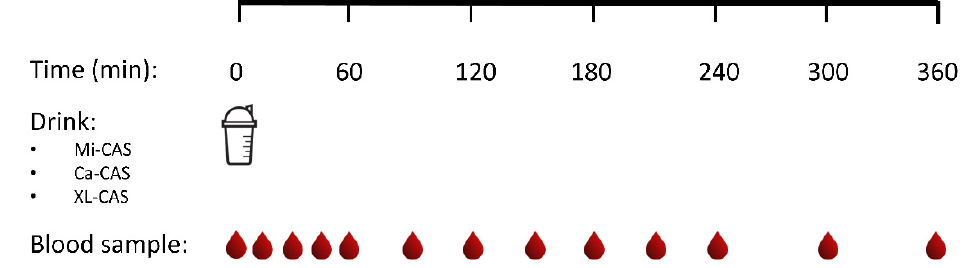
Figure 1. Schematic study representation. Ca-CAS: caseinate protein; XL-CAS: cross-linked casein protein; Mi-CAS: micellar casein protein.